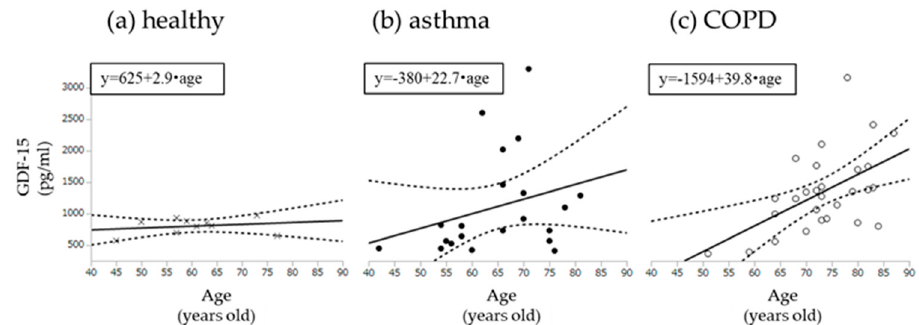
Figure 4. Univariable models for age with GDF-15. ( a ) Correlation with age and GDF-15 among healthy subjects; ( b ) Correlation with age and GDF-15 among asthma; ( c ) Correlation with age and GDF-15 among COPD. GDF-15: Growth Differentiation Factor-15. Dotted lines show 95% confidence intervals.